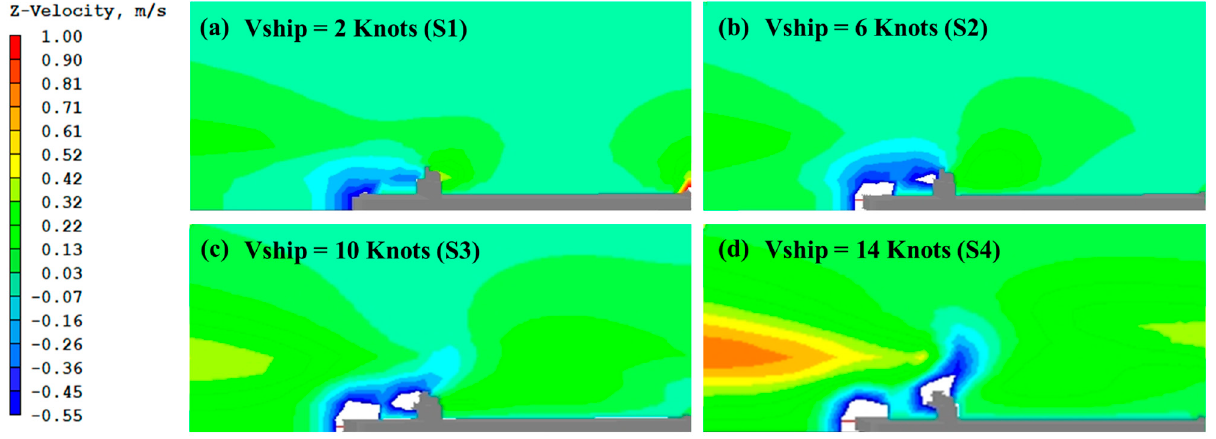
Figure 11. The vertical velocity contours near the hull in the V2 − T2 scenario with wind speeds of 3 m/s: ( a – d ) are S1, S2, S3, and S4 scenarios, respectively.